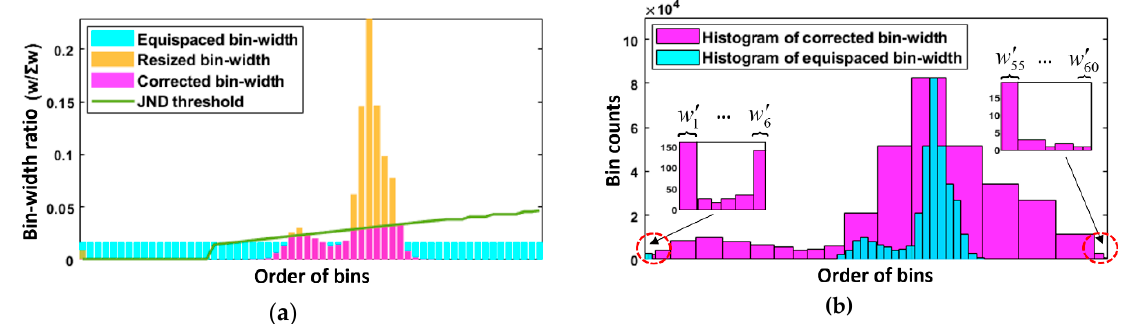
Figure 5. Illustration of the proposed bin width adjustment approach in two aspects. ( a ) Comparison in terms of the output bin width ratios. ( b ) Comparison in terms of the output histograms.